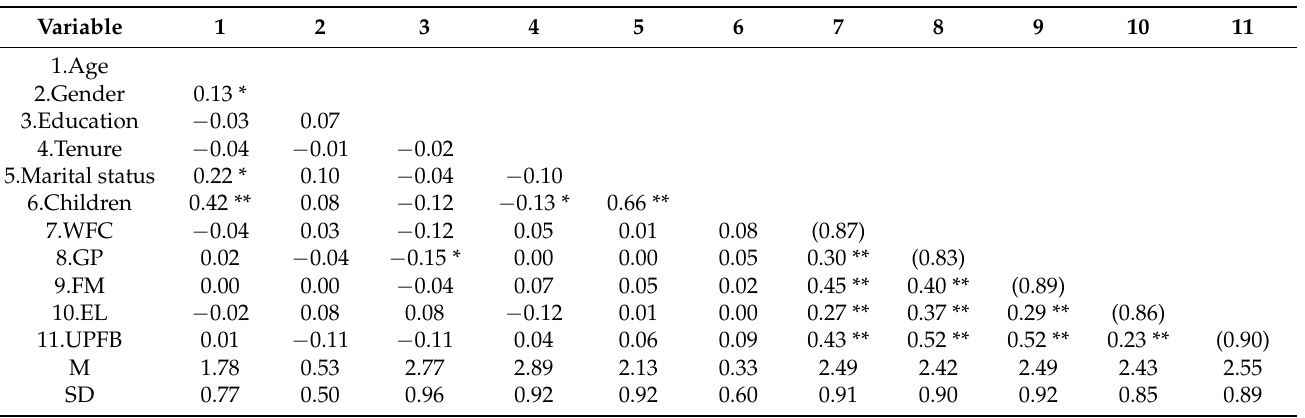
Table 2. Descriptive Statistics in the Study